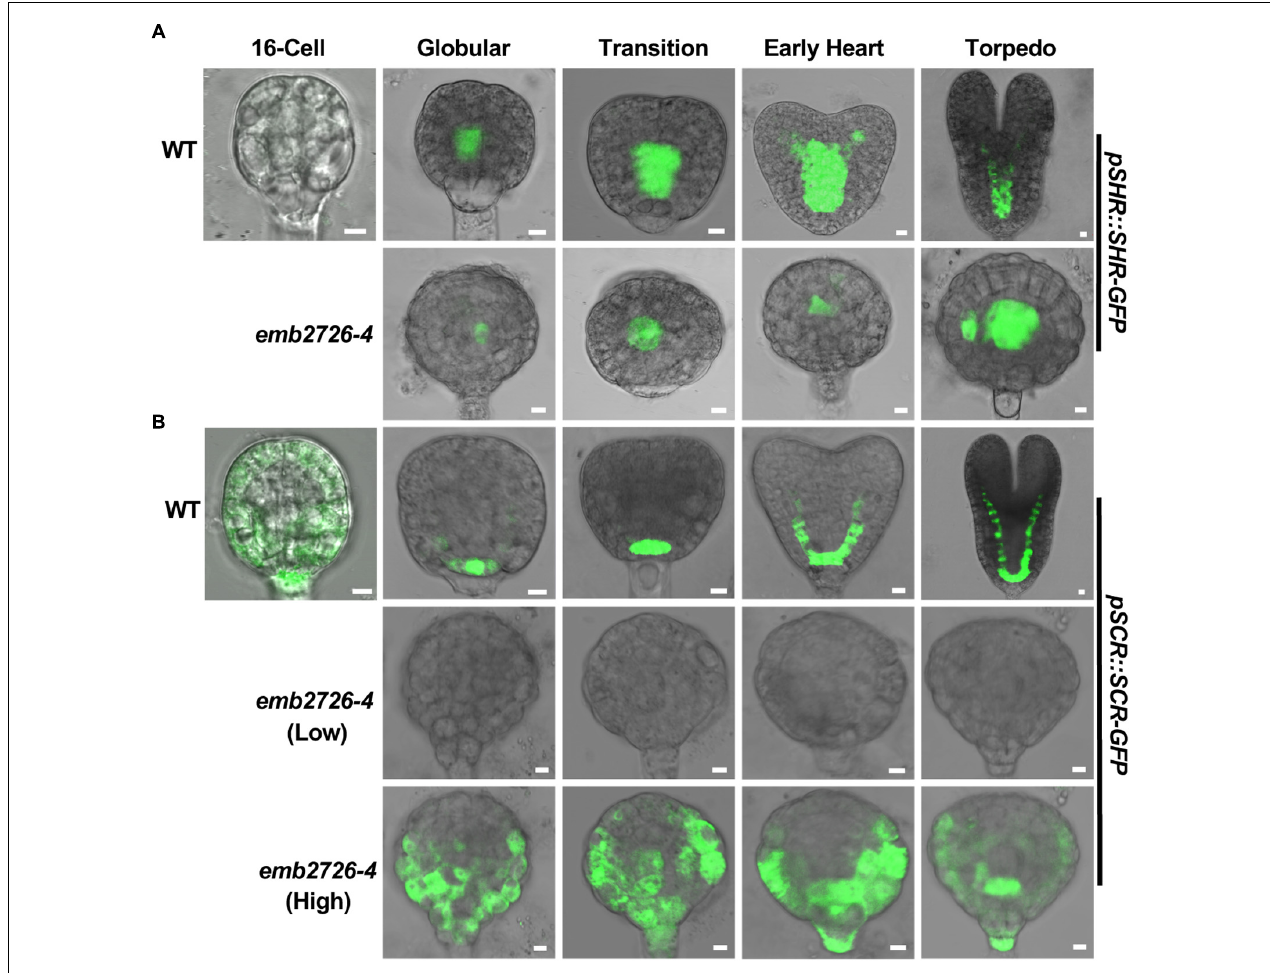
FIGURE 7 | Initiation of the procambium and the ground tissue is disrupted in emb2726-4 embryos. Expression patterns of pSHR:SHR-GFP (A) and pSCR:SCR-GFP (B) in WT and emb2726-4 embryos at different developmental stages. The terms “Low” and “High” in parentheses indicate the excitation power used. A minimum of 50 embryos were observed for 16-cell stage embryos, and 30 WT and 30 mutant embryos were observed for each of the later developmental stages. Scale bar = 10 µ